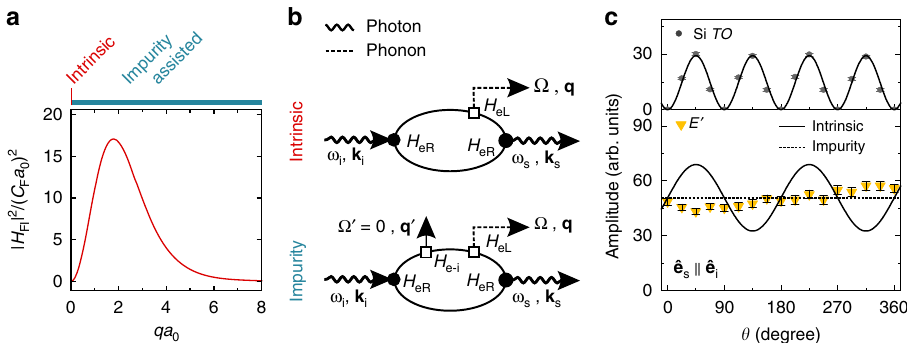
Fig. 3 Impurity assisted Fröhlich scattering. a Plot of the matrix element of the exciton-phonon Fröhlich interaction in dependence of the product of the phonon wave vector q and the exciton radius a 0 . See Supplementary Note 2 for details. For the intrinsic fi rst-order process qa 0 ≈ 0.02, while in the impurity assisted process q can take arbitrary values. The qa 0 dependence of | H FI | 2 is qualitatively independent of a 0 . b Feynman diagrams for the scattering of a photon with frequency ω and momentum k from initial state i to fi nal state s by emitting a phonon with frequency Ω and momentum q . Upper panel: intrinsic fi rst-order Raman process. Lower panel: second-order process involving elastic scattering with an impurity. H eR denotes the electron-radiation interaction; H eL is the electron lattice interaction, which can be either DP or FI. H e-i represents the electron-impurity interaction for the elastic scattering with momentum transfer q ’ . We show only one permutation of the interactions. c Resonant Raman intensities ( E i = 1.96 eV) for linear parallel polarization ( ê i = ê s ) for one whole rotation of the angle θ between ê i,s and the crystal axes. Lower panel: amplitude of the E ’ mode (yellow triangles). Fitted amplitudes are plotted as scatters. The line plots show the calculated polarization dependences of the intrinsic and the impurity-assisted exciton-LO phonon scattering processes (solid and dashed lines, respectively). Upper panel: amplitude of the TO mode of the silicon substrate used as a reference signal (Scatters: measured data, Line plot: simulated data). Spectra are shown in Supplementary Fig.